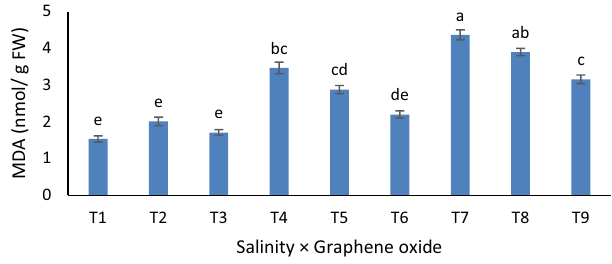
Figure 1. Mean comparison for the interactions of salinity stress and soil-based application of graphene oxide on malondialdehyde content in grapevine. Similar letters show no meaningful difference at 5% probability level by Duncan’s Multiple Range Test. Data are mean ± SD (n = 3 replicates). T1: NaCl 0 × graphene 0 , T2: